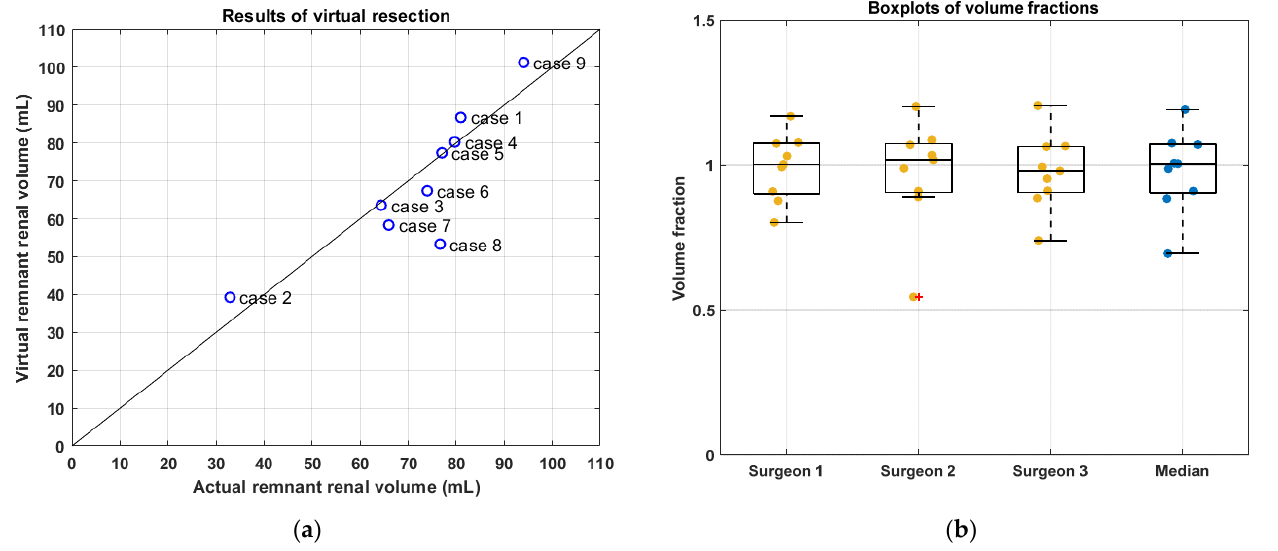
Figure 2. Results of virtual resection. In ( a ), the average virtual and the actual postoperative volume per case are shown. The black line implies a volume fraction equal to one, which corresponds to perfect agreement between the virtual and actual postoperative volume. In ( b ), the volume fraction per case is shown per surgeon and the median. Table 2. The RRVs per surgeon for all nine operative cases.